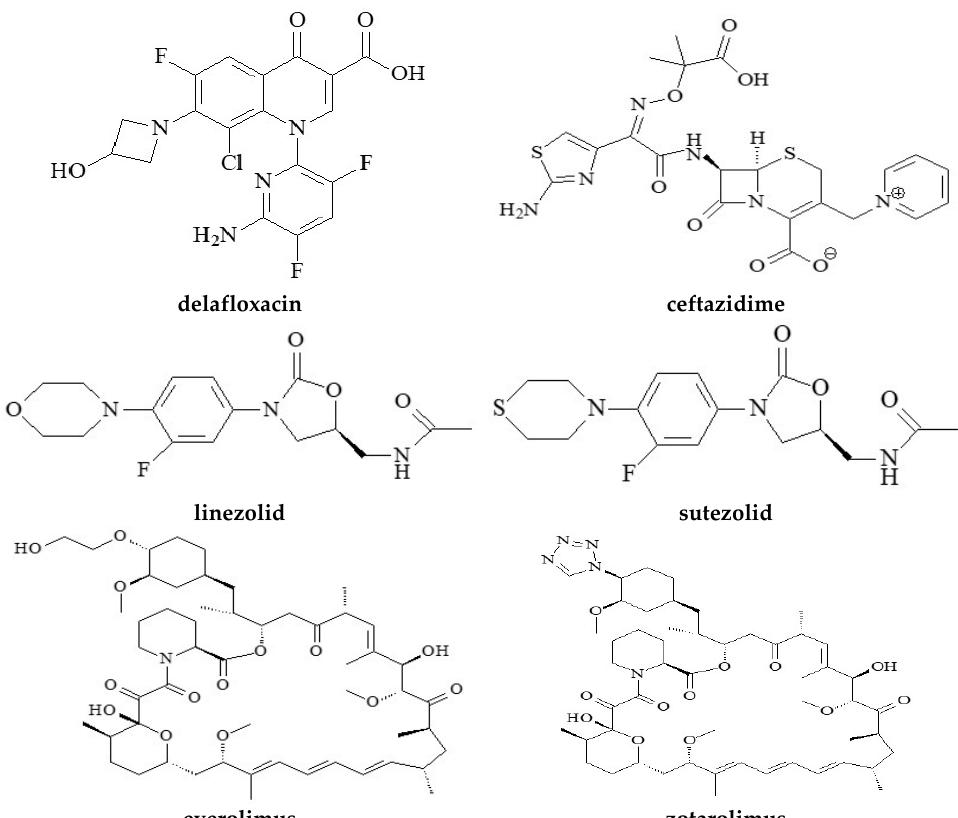
Figure 1. Structures of tested compounds .